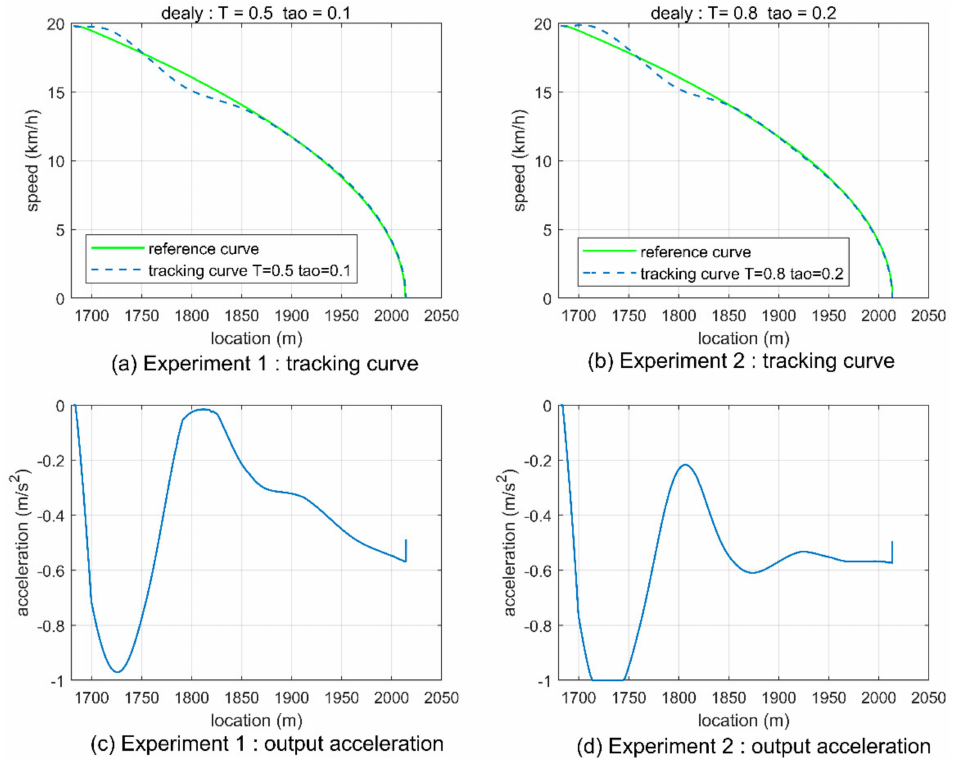
Figure 19. Comparison of adaptive terminal sliding mode controller (ATSMC) and ATSMC + disturbance observer (DOB): ( a ) Comparison in speed curve; ( b ) Comparison in speed error.